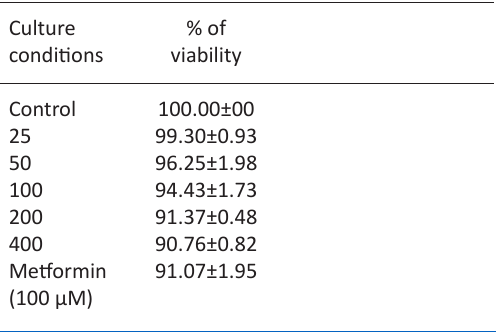
Table 3. Cell viability effects of A. suaveolens extract in 3T3-L1 cell line